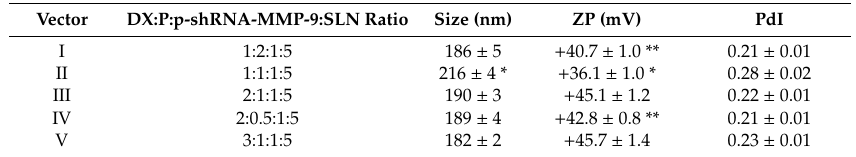
Table 1. The characterization of nanovectors bearing the p-shRNA-MMP-9 plasmid. Size (nm), Zeta potential (mV), and polydispersity index are presented as mean ± SD ( n = 3).